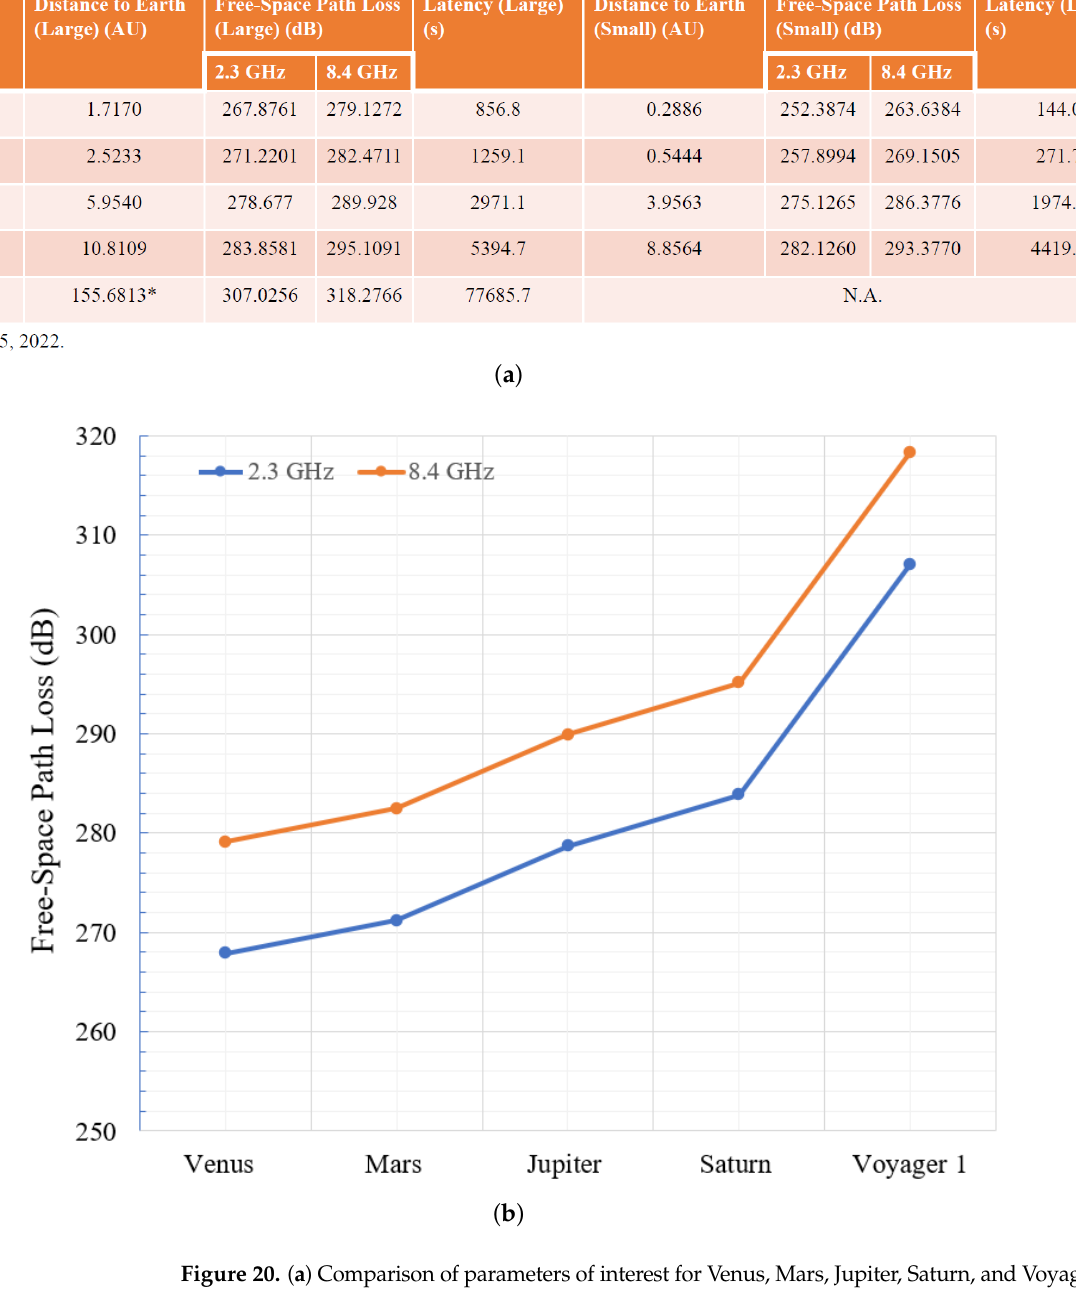
Figure 20. ( a ) Comparison of parameters of interest for Venus, Mars, Jupiter, Saturn, and Voyager 1; and ( b ) Comparison of free-space path loss (large distances for planets) at 2.3 GHz and 8.4 GHz,